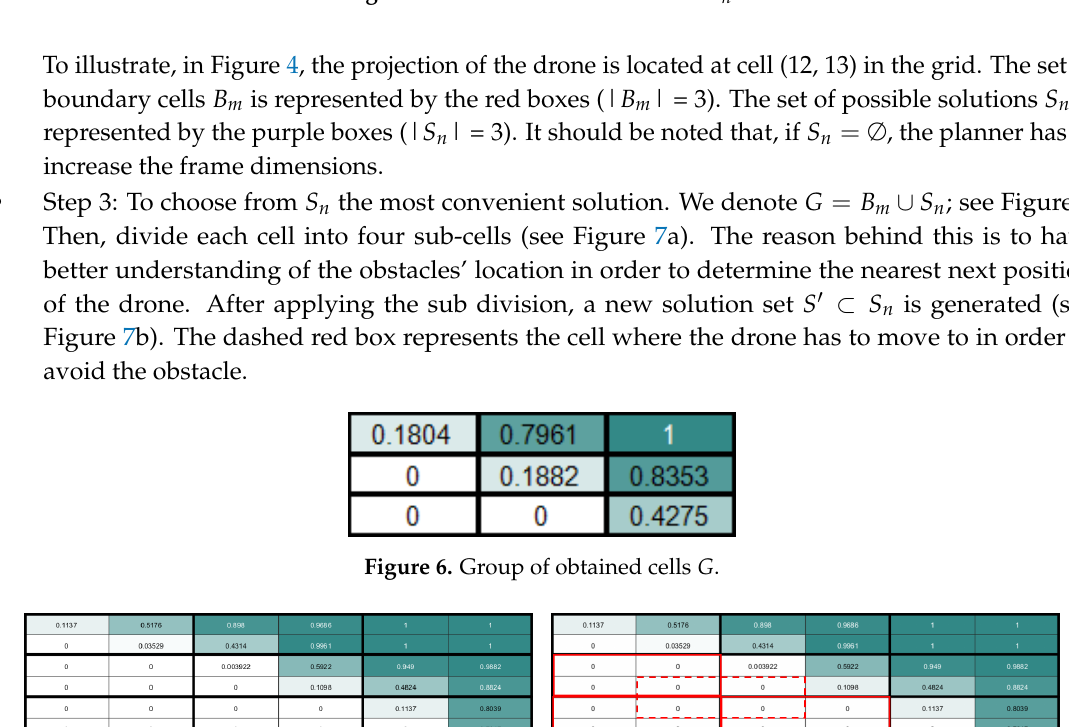
Figure 5. Determine set of Solutions S n .